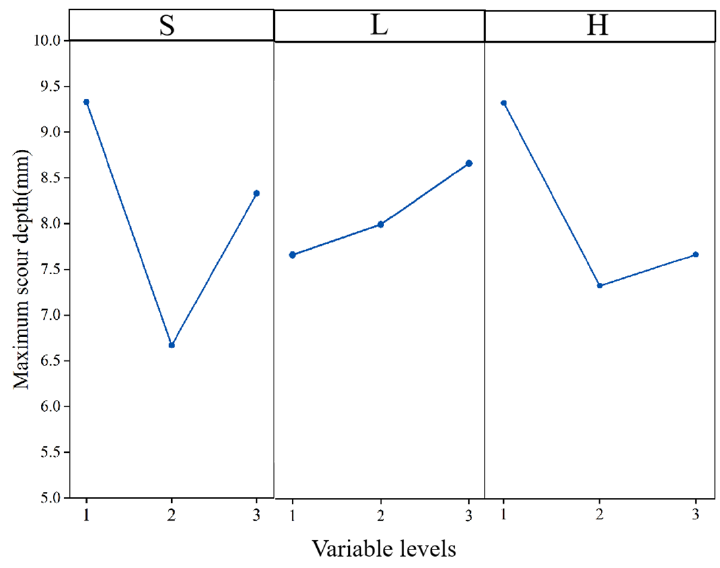
Figure 6. Main-effect plots of the scour depth.